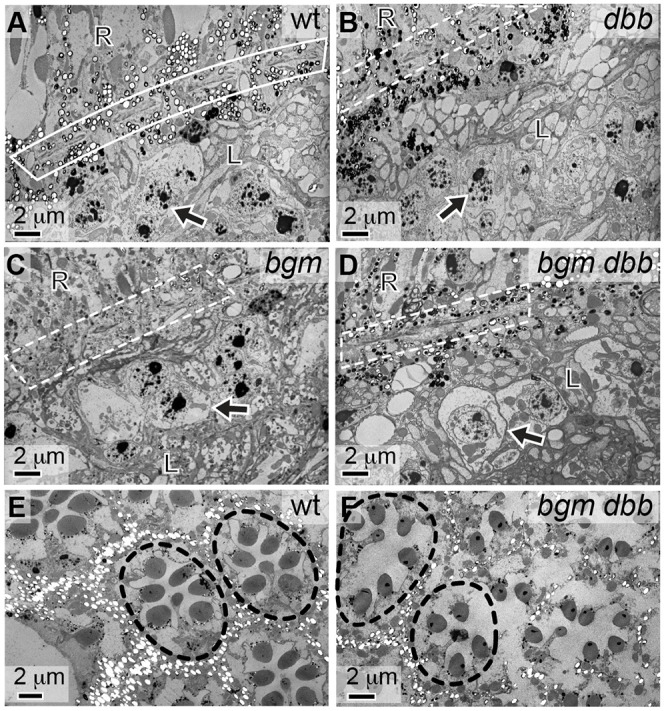
Neuronal death and pigment cell defects in Acyl-CoA synthetase mutants. Ultrastructural analysis of heads from 18-day-old (A) wild-type (wt), (B) dbb1, (C) bgm1 and (D) bgm1 dbb1 flies. In wild-type animals, the fenestrated membrane appears as membrane with pores (boxed in panel A). Only a thinned or barely visible membrane is visible in mutant animals (boxed in panels B-D). Also, lytic death of monopolar neurons is evident in the lamina of mutant, but not wild-type, animals. In A-D, monopolar neurons are indicated by arrows; R denotes the retinal domain; L denotes the laminal domain. Ultrastructural analysis of retinas from 18-day-old (E) wild-type and (F) bgm1 dbb1 flies. Loss of the ommatidial structure (outlined) in the bgm dbb double-mutant retina is correlated with loss of secondary pigment cells; these surround each ommatidial cluster of photoreceptor neurons and in these images appear as empty white structures due to pigment loss associated with processing (Cagan and Ready, 1989; Wolff and Ready, 1991).